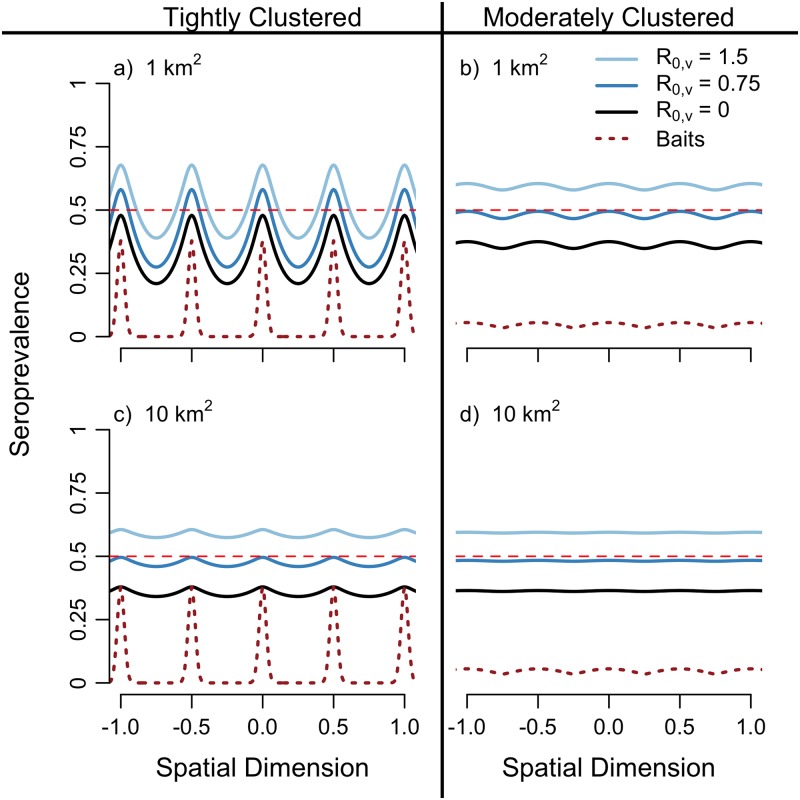
Spatially explicit seroprevalence achieved with traditional and transmissible vaccines.The host home range is set to coincide with typical home ranges of raccoons: 1 km2 (panes a and b, k = 0.01) and 10 km2 (panes c and d, k = 0.1). The vaccine bait heterogeneity is either tightly clustered (ξ = 0.025, left column) or moderately clustered (ξ = 0.25, right column). The brown dashed line depicts the steady state distribution of vaccine, scaled for visibility. Other parameters: d = 0.416 yr−1, σ = 0.24 yr−1, δv = 12 yr−1.